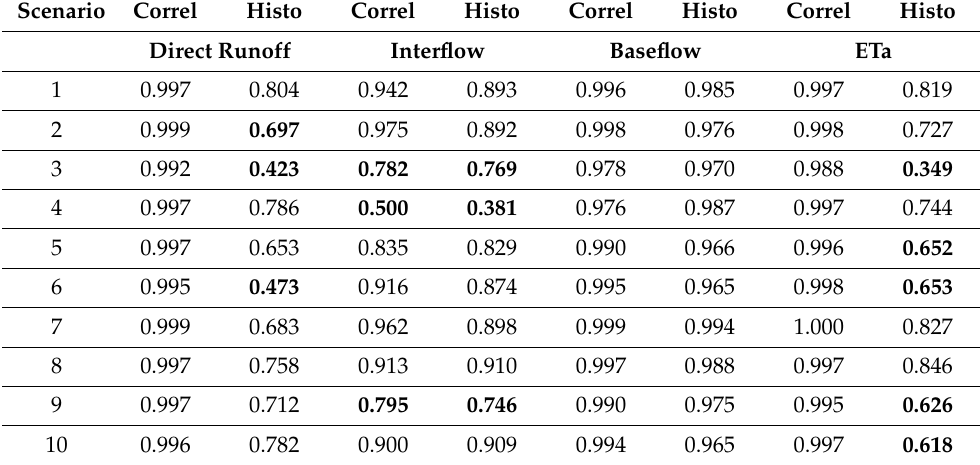
Table 8. Spatial correlation (correl) and histogram overlap (histo) of the 10 scenarios compared to the baseline scenario, for spatial mean of direct runoff, Interflow, baseflow, and ETa. Scenario Correl Histo Correl Histo Correl Histo Correl